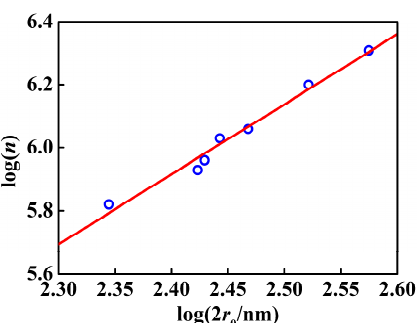
Figure 10. Logarithmic plots of n (the number of the carboxyl moiety per PSA nanosphere) against diameters of PSA nanospheres, 2 r 0 .